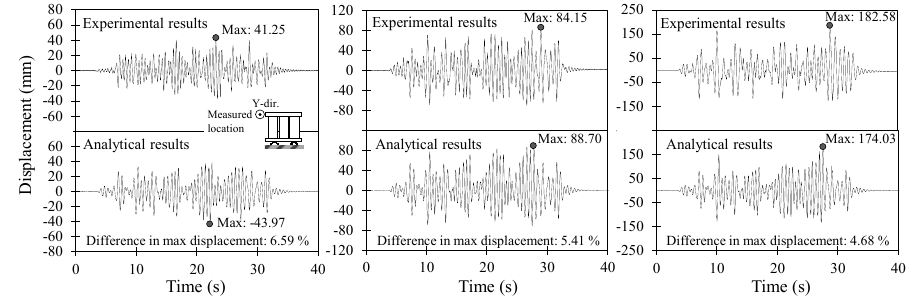
Figure 9. Comparison of displacement–time history responses in Y-direction between analytical and experimental